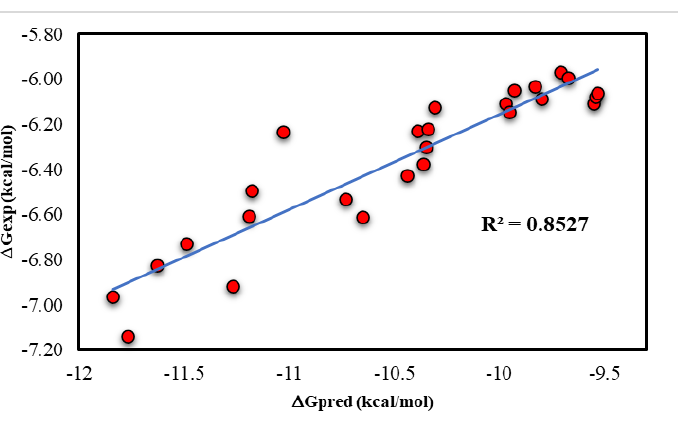
in moles. Energy is measured in kilocalories per mole. As a result, the plotting of experi- mental binding free energies against the computed values gave a relative high correlation coefficient of R 2 = 0.85 which suggesting the reliable of the docking study (Figure 2). It is also interesting to note that, among studied compounds, ursolic acid has been reported for its significant effect against HepG2 cell lines using mouse xenograft tumor models [32]. According to Liu et al. [33], ursolic acid could suppress HepG2 tumor growth in a time- dependent manner when tested at a concentration of 2.6μmol in 100 μL per day. These data further suggest the potential activities of this class of compound.